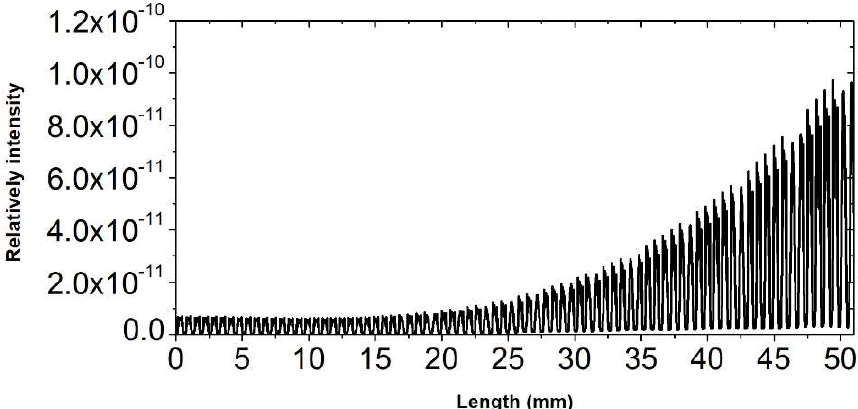
Figure 18. Power curve of the pre-amplification section.